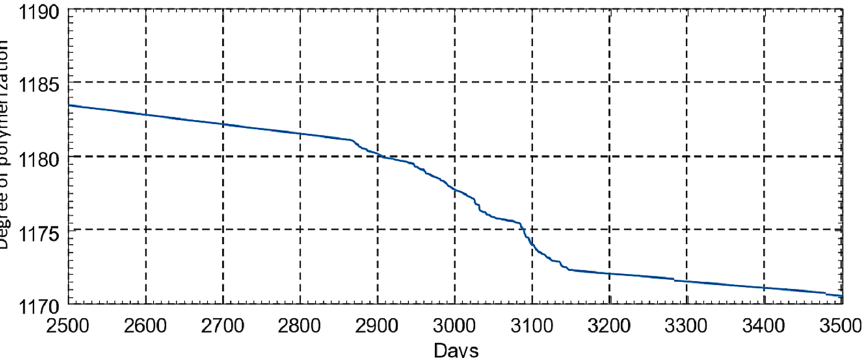
Figure 51. Simulation of the degree of polymerization for days in which there are data on the water content in the paper.